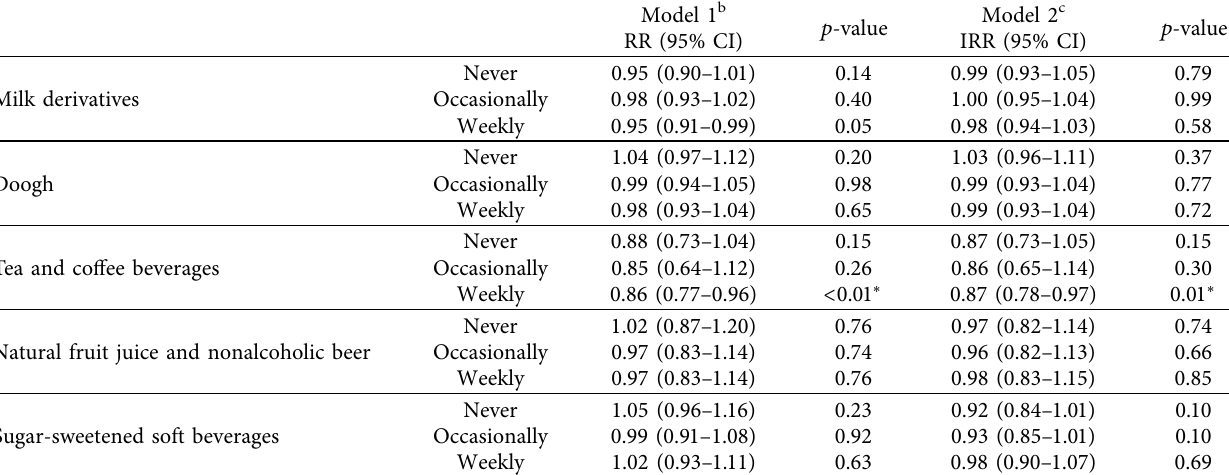
Table 3: Modeling DMFT based on negative binominal regression model a